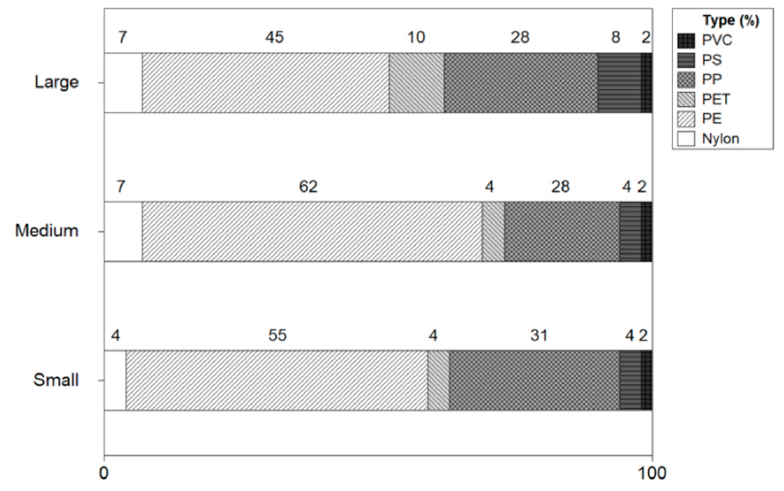
Figure 9. Types of microplastics by size of shrimp.